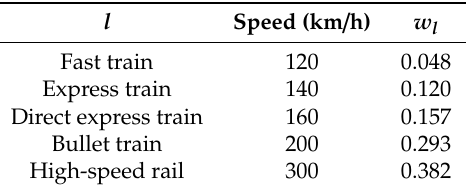
Table 2. Type of trains and respondent weights.